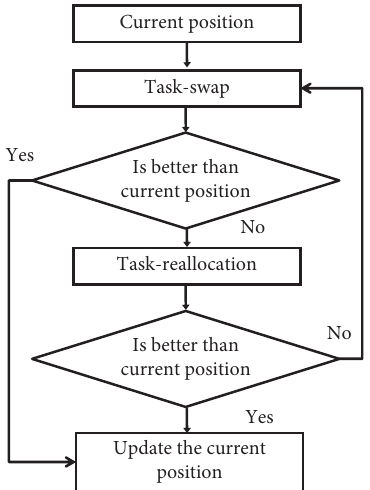
Figure 7: Vision-based search